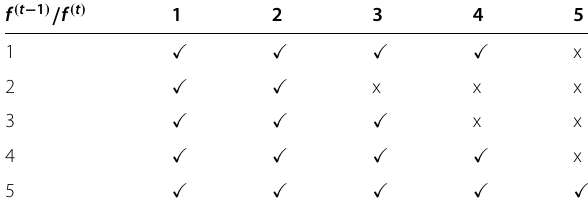
Table 1 Possible ( (cid:2) )and impossible(x) finger transitions for ascending scale by the left-hand and descending scales by the right-hand in which the hand does not